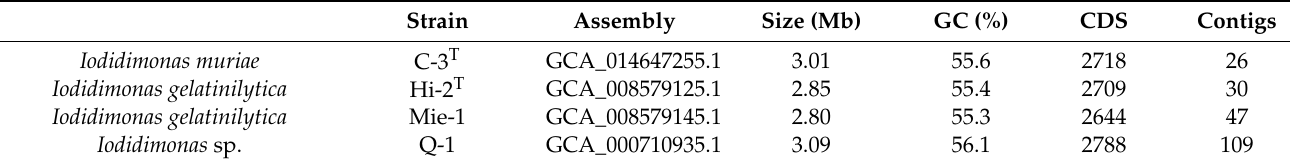
Table 2. Genome assembly and annotation data of Iodidimonas